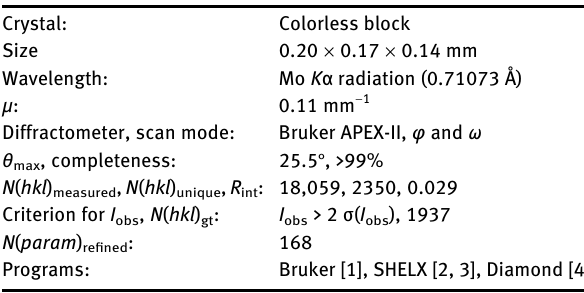
Table 1 contains crystallographic data, and Table 2 con-